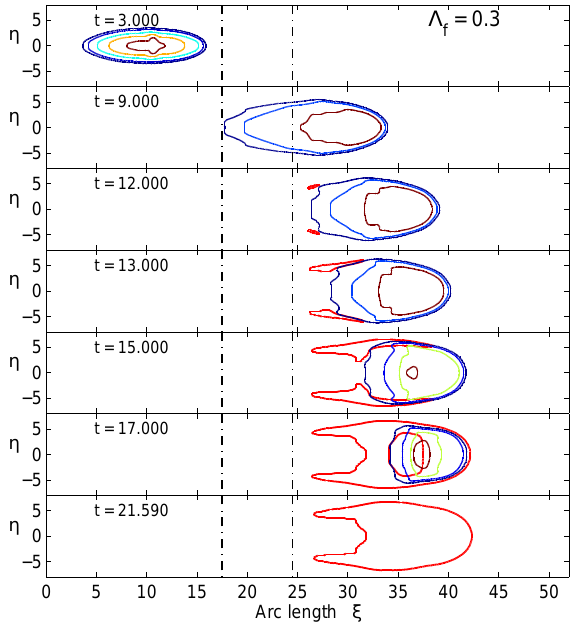
Fig. 7. Contour plots of the flowing mass and the evolution of the deposition heap, where Λ f = 0 . 4 with the deposition procedure be- ing adopted in the computation.